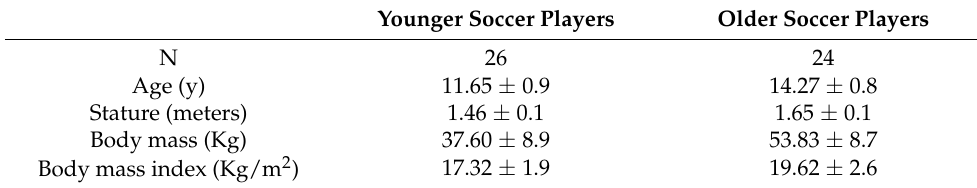
Table 1. Players’ demographic